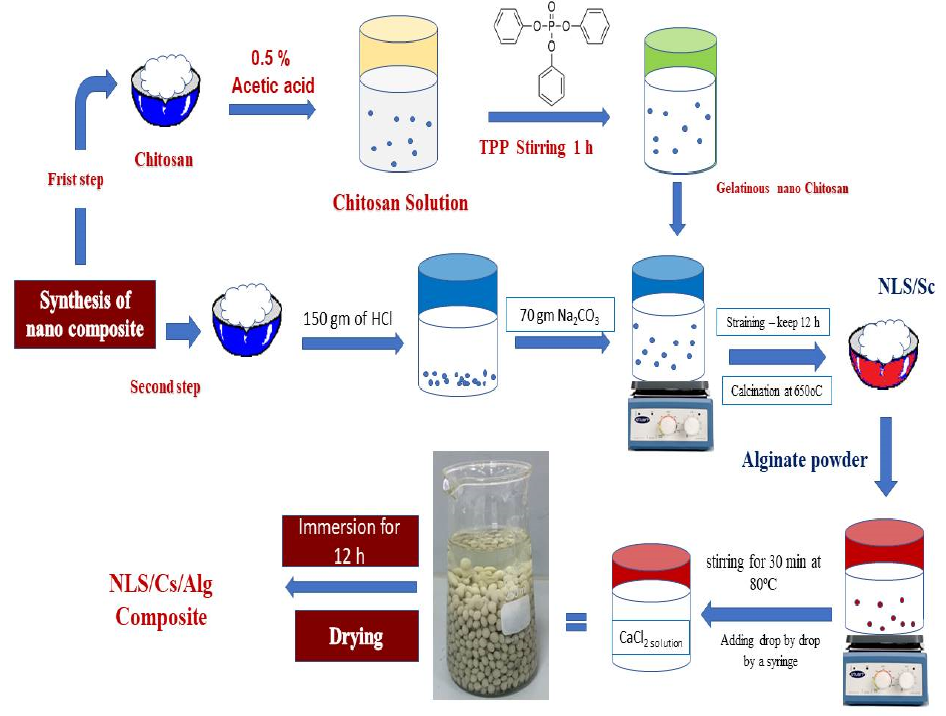
Figure 6. Flowchart of the NLS/Cs/Alg. formation.